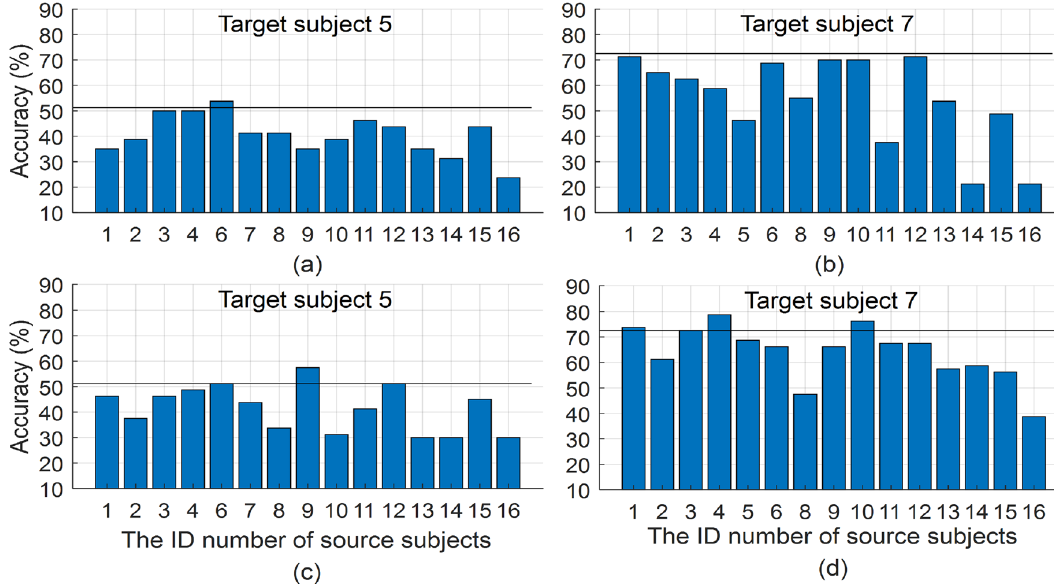
Figure 4. Classification accuracies of two target subjects (#5 and #7) yielded by the two transfer learning algorithms TL ( a , b ) and TL-LEDA ( c , d ) with the EEG trials of only one source subject transferred to the target subject. The sold line in each subplot stands for the accuracy yielded by SSL (baseline)